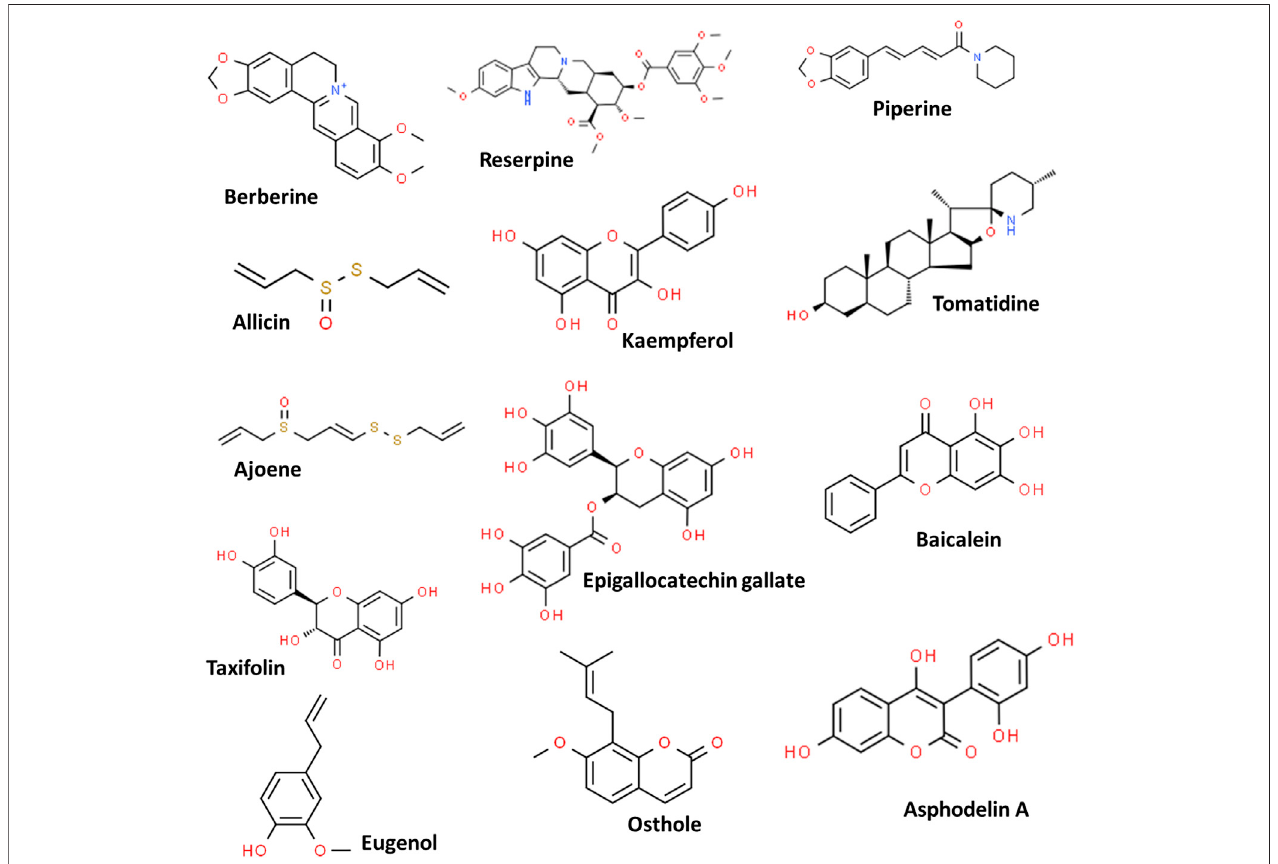
FIGURE 2 | Some potent phytochemicals used against the multidrug-resistant pathogens.